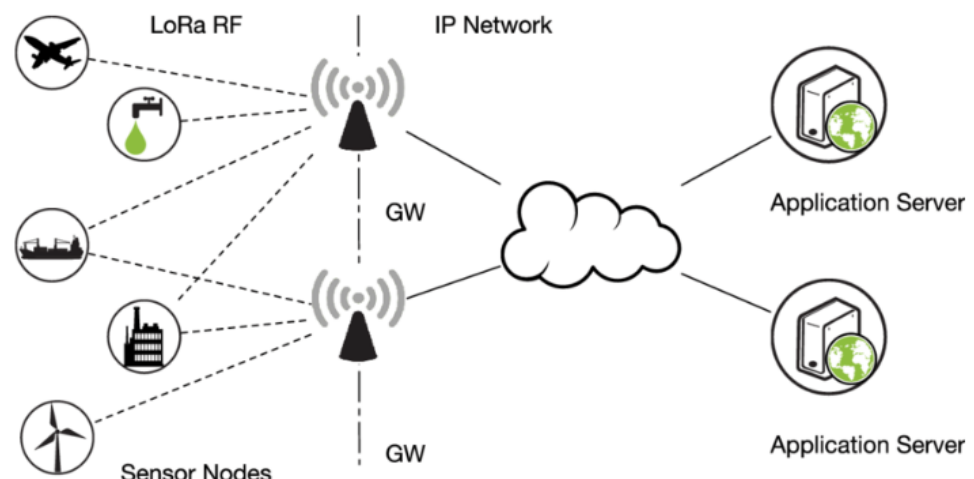
Figure 1. LoRaWAN architecture.